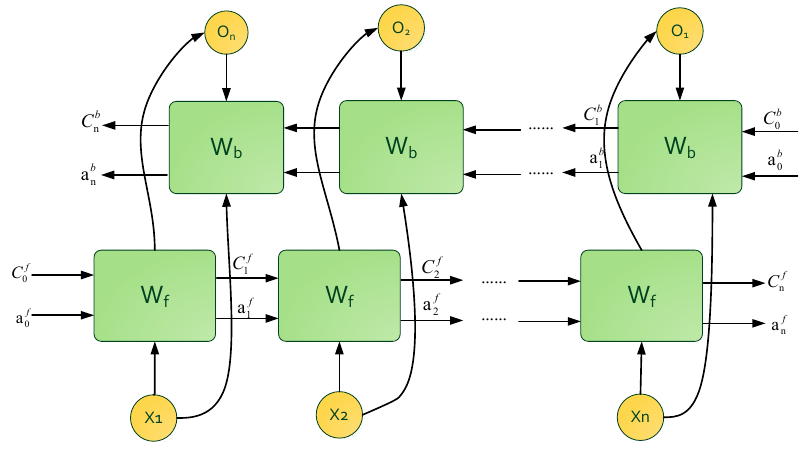
Figure 4. Structure of BiLSTM.